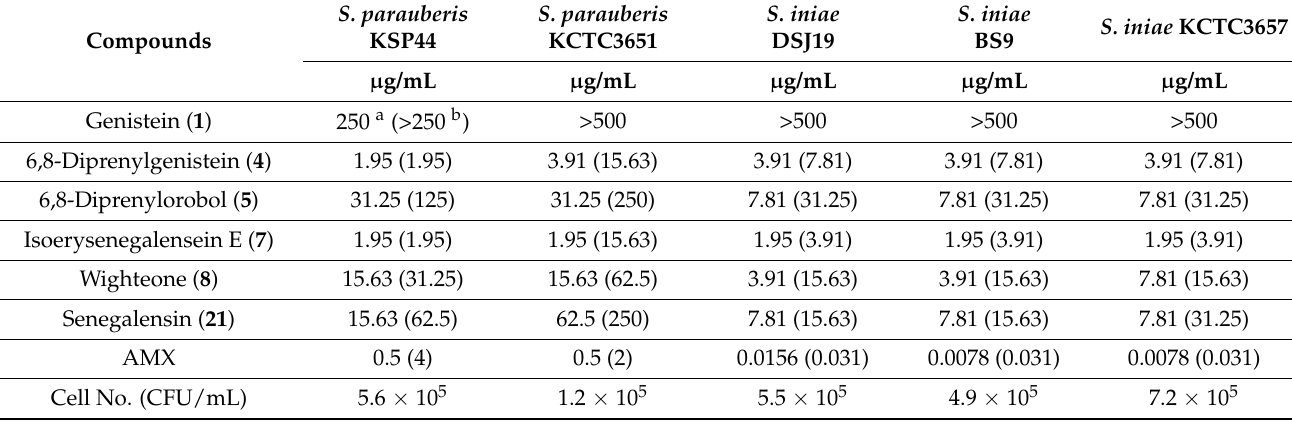
Table 2. Antibacterial activities of prenylated isoflavones from M. tricuspidata against fish pathogenic Streptococcus strains.